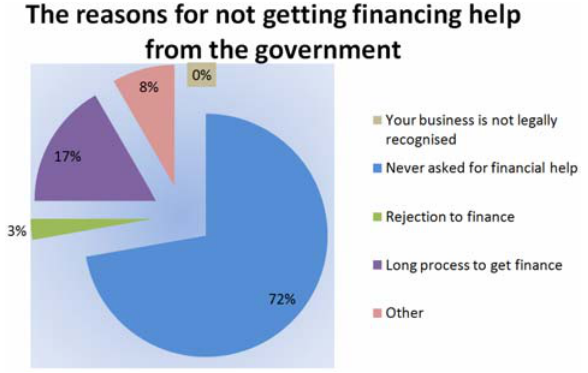
Fig. 5. Reasons for not getting financing help from the